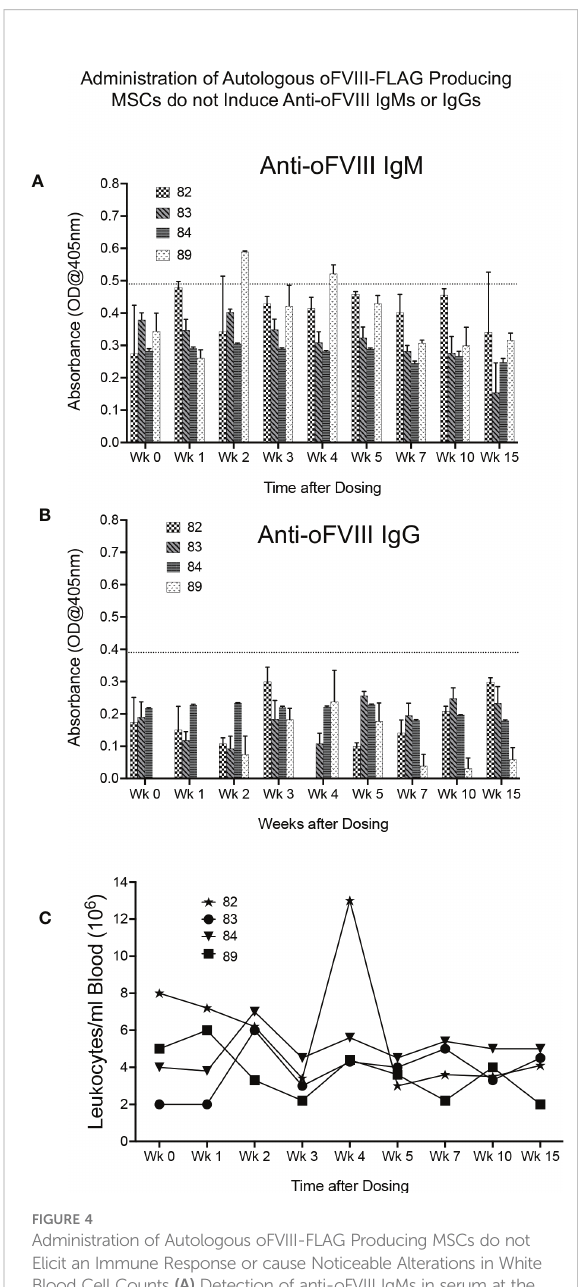
FIGURE 4 Administration of Autologous oFVIII-FLAG Producing MSCs do not Elicit an Immune Response or cause Noticeable Alterations in White Blood Cell Counts (A) Detection of anti-oFVIII IgMs in serum at the lowest dilution of 1:20, for each animal, at each timepoint, measured by ELISA (based on the background observed in a panel of negative control sheep, only signals above 0.49 were deemed to be positive) (n=3). (B) Detection of anti-oFVIII IgGs in serum (1:20 dilution) for each animal at each timepoint, measured by ELISA. Based on the background observed in a panel of negative control sheep, only signals above 0.3 were deemed to be positive (n=3). (C) White blood cell counts/ml of blood in each animal prior to and for 15 weeks after injections of autologous